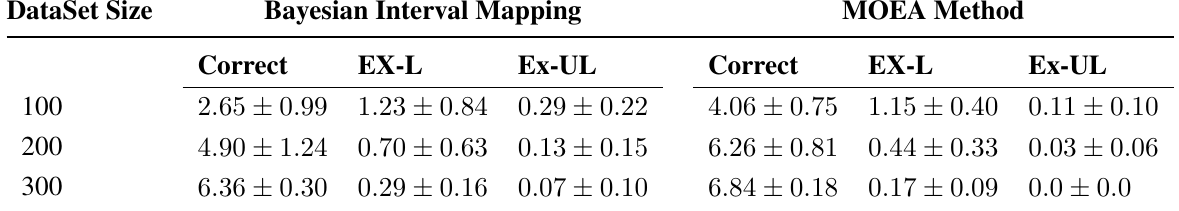
Table 3. Case II: MOEA vs . Bayesian Interval Mapping : Comparative results of the MOEA approach vs . Bayesian Interval Mapping method using Windows QTL Cartographer version 2.5 with complexity of 7.